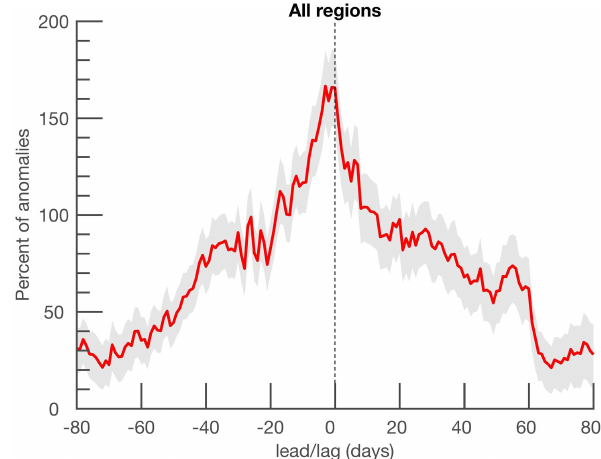
Figure 7. Composites of local simulated probabilities (expressed as percent with respect to the mean seasonal cycle, i.e., 100% indi- cates that probabilities are two times higher than normal) relative to the large-wildfire ( > 100ha) days. The 95% confidence inter- vals of the composite means are computed using 1000 bootstrapped datasets. The envelope of confidence indicates the 2.5 and 97.5 per- centiles of the composite means obtained from the bootstrapped